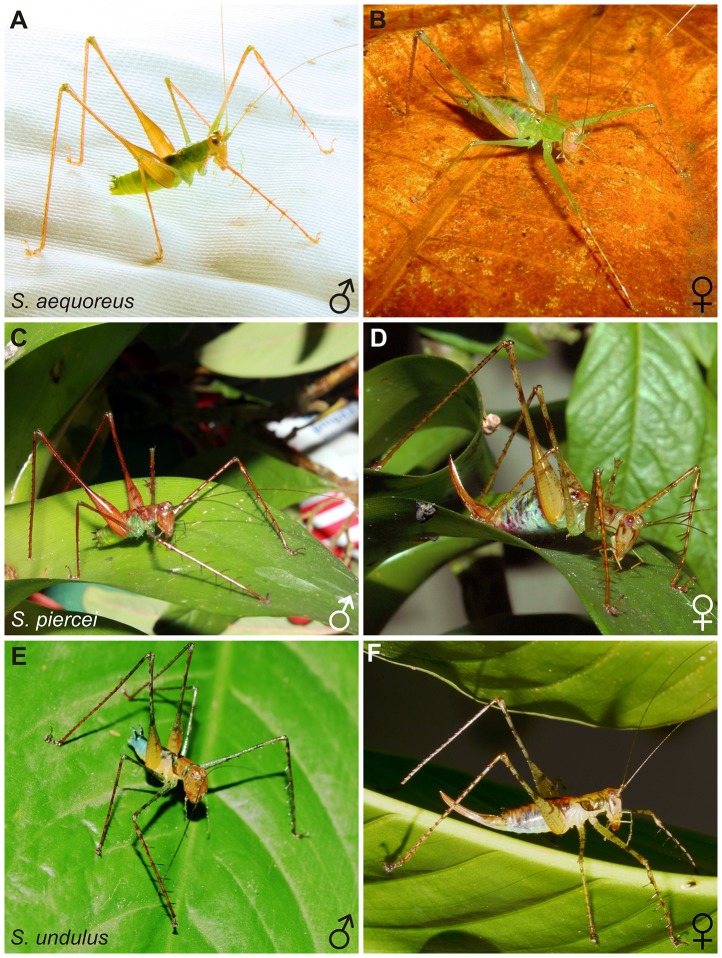
Morphological comparision of Supersonus spp. habitus.(A, B) Male and female of S. aequoreus. (C, D) Male and female of S. piercei, and (E, F) Male and female of S. undulus. (A) Under a CC BY license, with permission from Natasha Mhatre, original copyright 2010. (C, D) Under a CC BY license, with permission from Manuel Jara, original copyright 2014. (B, E, F) Under a CC BY license, with permission from Fernando Vargas-Salinas, original copyright 2011.